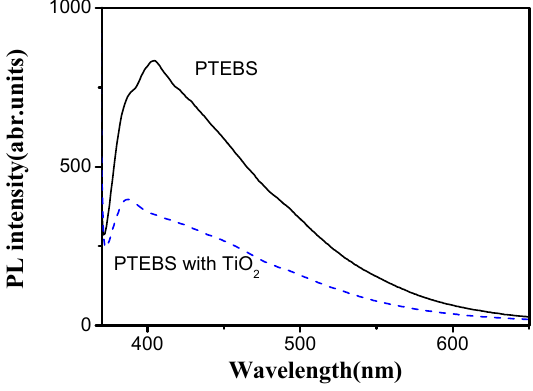
Figure 5 Photoluminescence of PTEBS/TiO 2 water solution. Figure 5. Photoluminescence of PTEBS/TiO 2 water